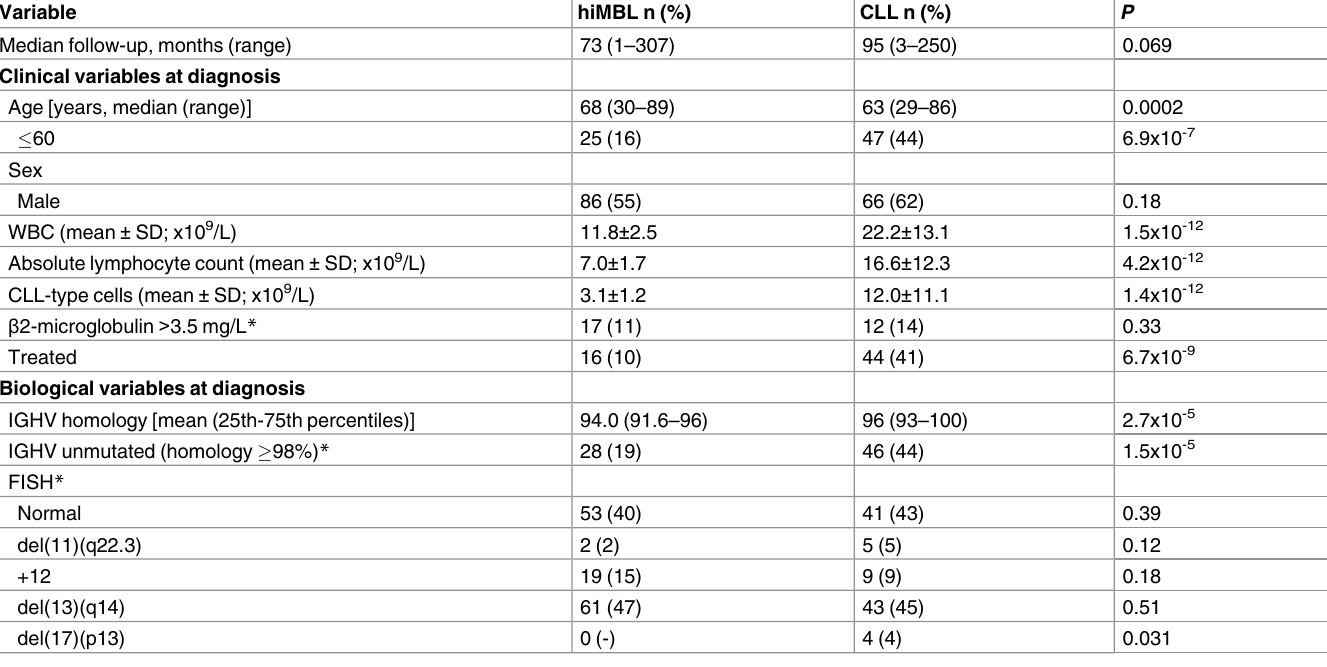
Table 1. Biological and clinical characteristics of hiMBL (n = 156) and Binet A CLL (n = 107) cohorts at